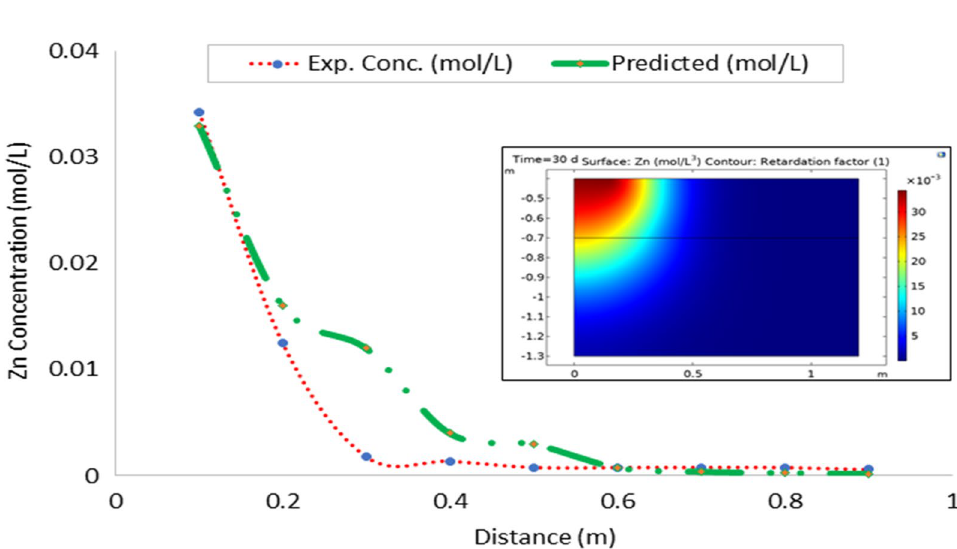
Figure 12. Zn transport in dumpsite soil of the study